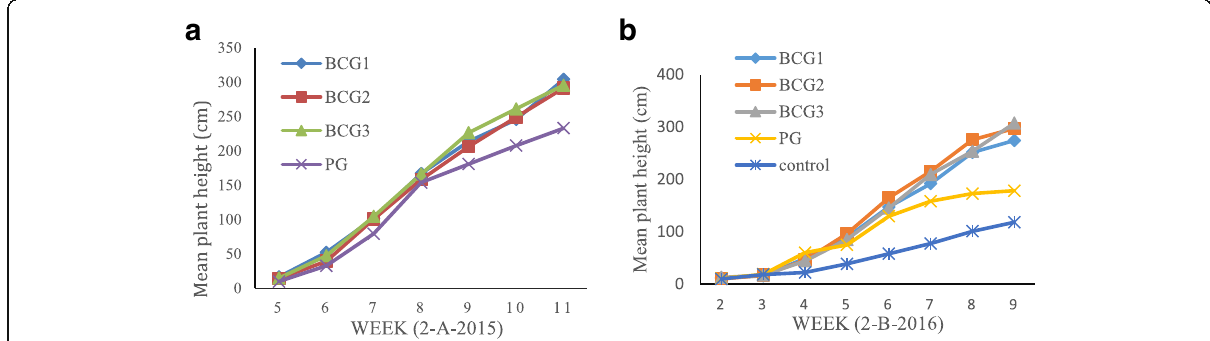
Fig. 2 a , b Mean plant height (cm) in treatments of controlling cucumber pests in greenhouses in the summer plantation, 2015 and